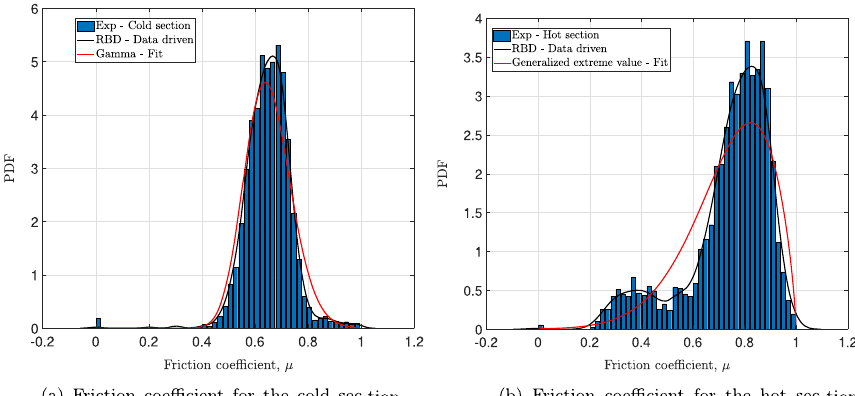
Fig. 1 Statistic behavior of the friction coefficient for the cold and hot sections. Comparison between the experiment through the histogram (reference), Kolmogorov–Smirnov test combined with the parametric estimation and the data-driven approach combined with